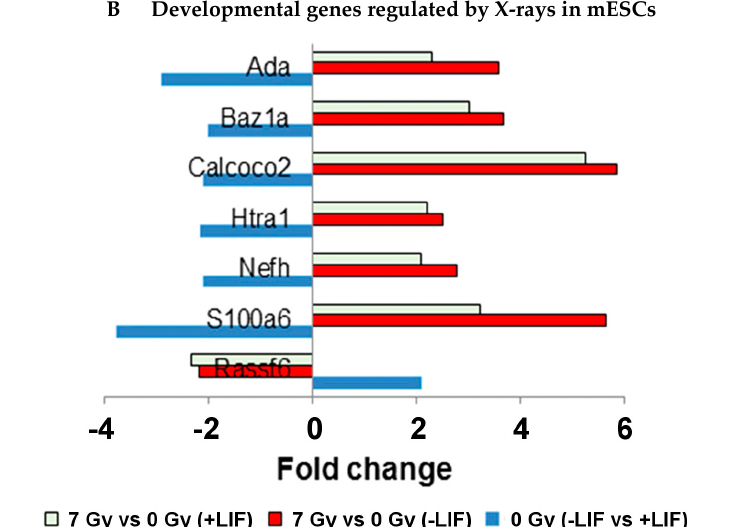
Figure 10. Characterization of X-ray deregulated genes. ( A ) The overlap analysis of the total number of genes whose expression was altered after exposure to X-rays and differentially expressed genes in the absence or presence of LIF with respect to 0 Gy (fold change ≥ ± 2, False Discovery Rate (FDR) corrected p -value < 0.05, detailed data are shown in supplemental material). ( B ) Developmental genes (0 Gy, w/o LIF vs. LIF) regulated by X-rays in the presence or absence of LIF.